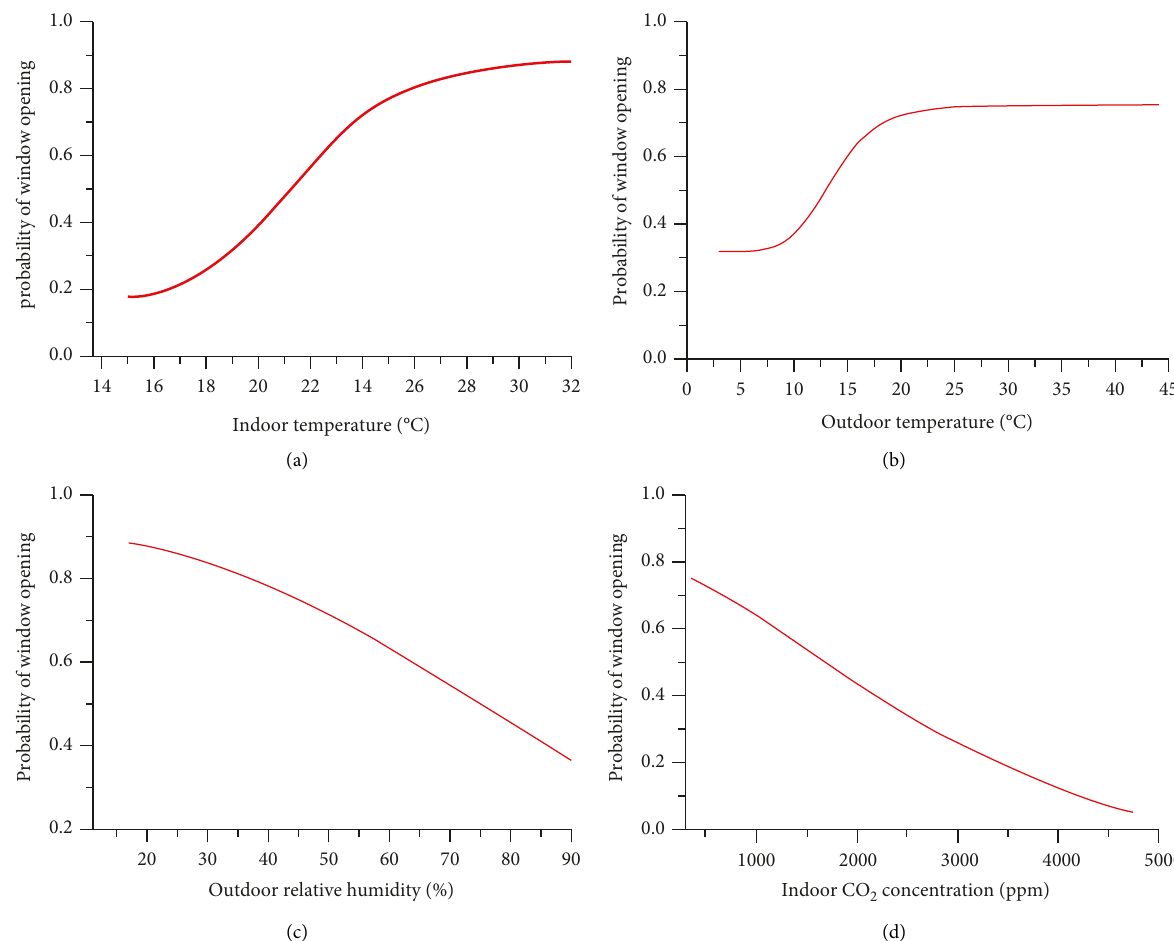
Figure 5: Relationship between environmental factors and window opening behavior: (a) the curve for indoor temperature and probability, (b) the curve for the outdoor temperature and of window opening probability of window opening, (c) the curve for outdoor RH and probability, and (d) the curve for indoor CO 2 concentration and of window opening probability of window